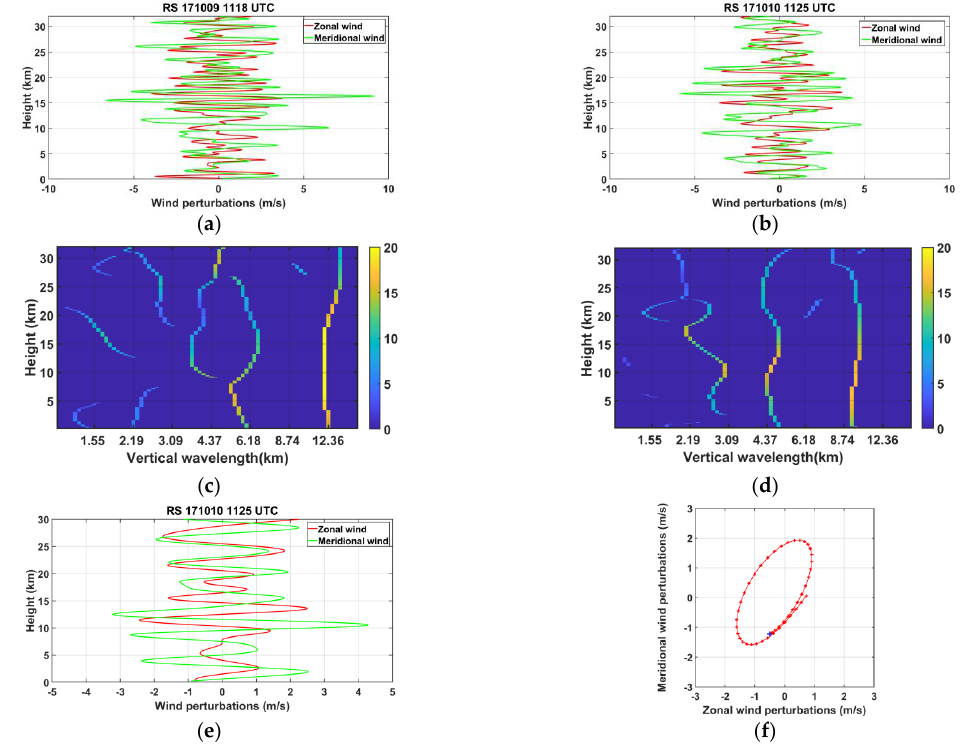
Figure 13. Vertical profiles of horizontal wind perturbations on ( a ) 9 and ( b ) 10 October 2017. Spectral lines resulted from the CWT maxima with values > 15% of the maximum CWT-coefficient absolute value for ( c ) the zonal wind perturbations on 9 October and ( d ) meridional wind perturbations on 10 October. ( e ) Filtered horizontal wind perturbations on 10 October 2017 with a pass-band filter with cutoff wavelengths of 3–7 km and ( f ) hodograph of horizontal wind at heights of 18.6–23.1 km. Blue and red dots indicate the lower altitude at 18.6 km height and vertical step of 100 m,